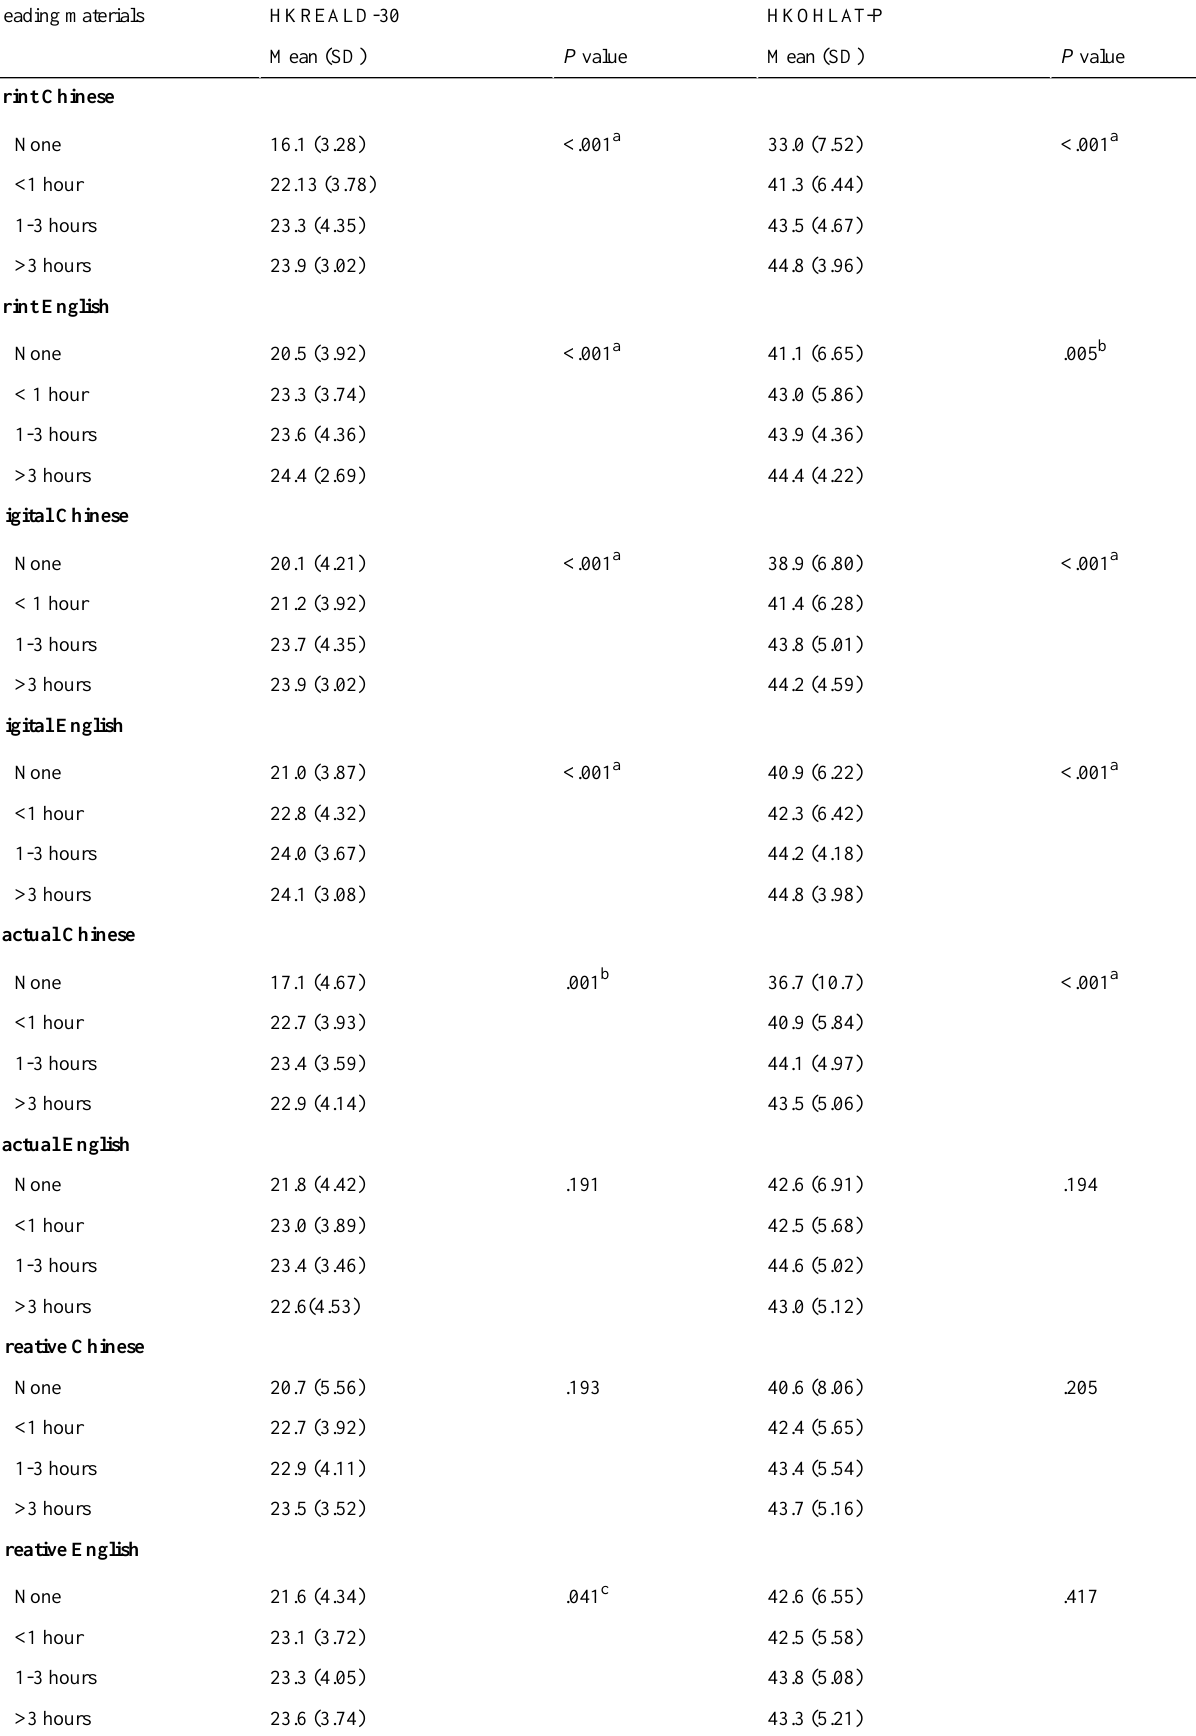
Table 1. Results (independent sample t test) showing bivariate variations between caregivers’reading habits and their OHL test scores (n=301 dyads). HKOHLAT-PHKREALD-30Reading